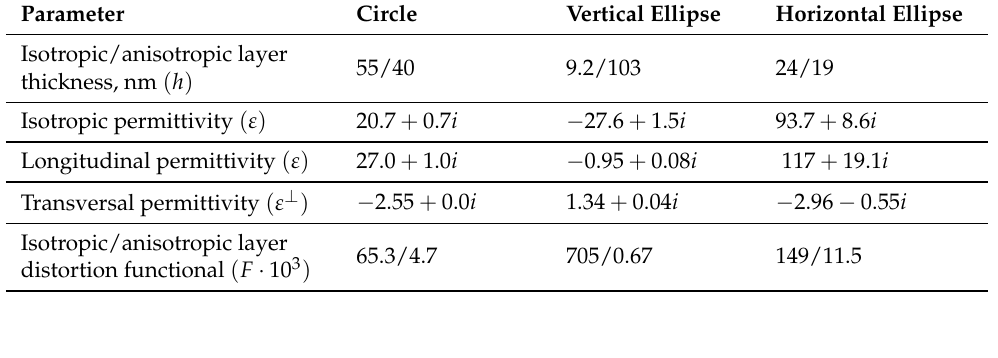
Table 1. Variational parameter results in isotropic and anisotropic layer models.